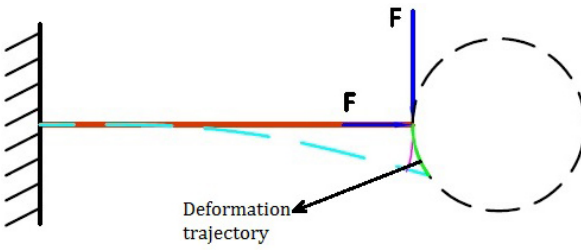
Figure 2. The deformation structure of the beams driven by a hy- brid combination of force.